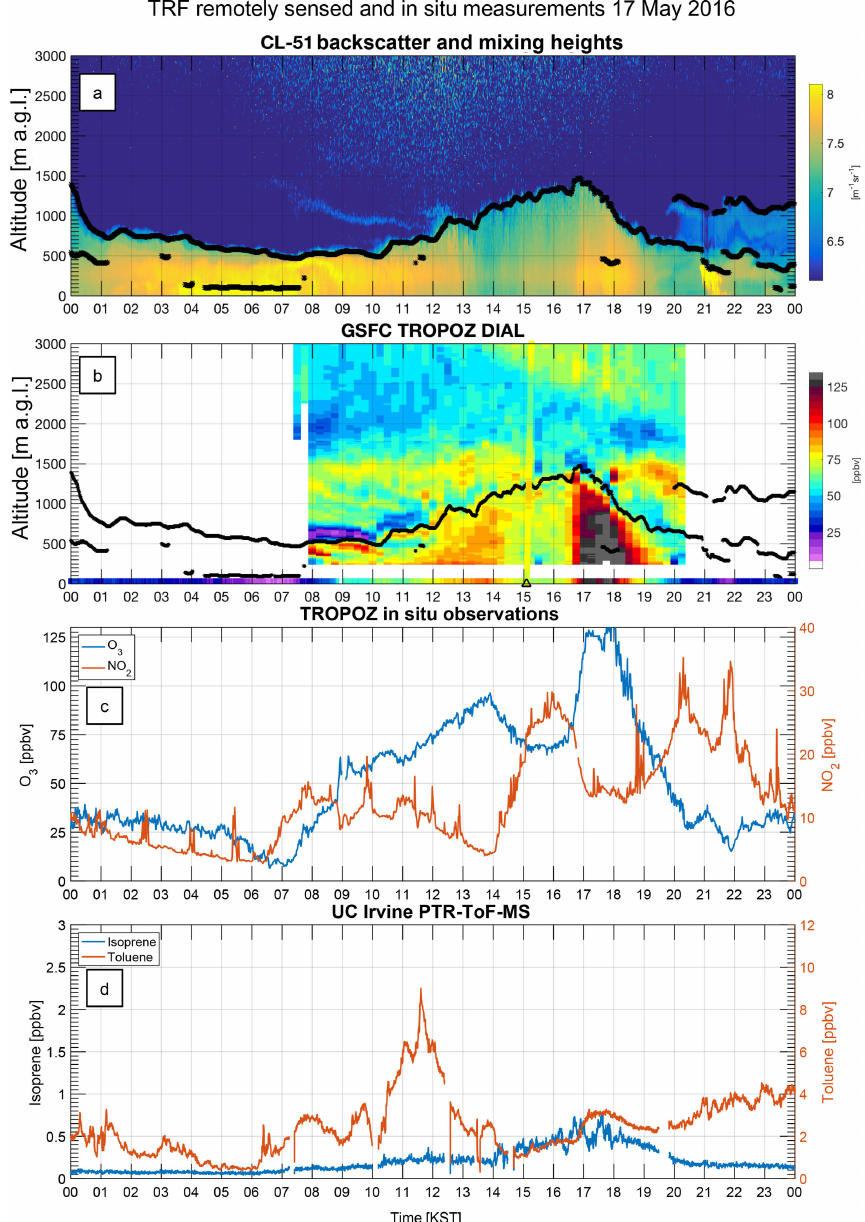
Figure 7. Time series of (a) ceilometer backscatter profiles and mixing heights, (b) GSFC TROPOZ DIAL O 3 profiles, (c) in situ surface O 3 and NO 2 , and (d) isoprene and toluene concentrations for 17 May 2016. Note: the DC-8 overpass occurred at around 15:30KST. The colocated ozonesonde is denoted in (b) with a black